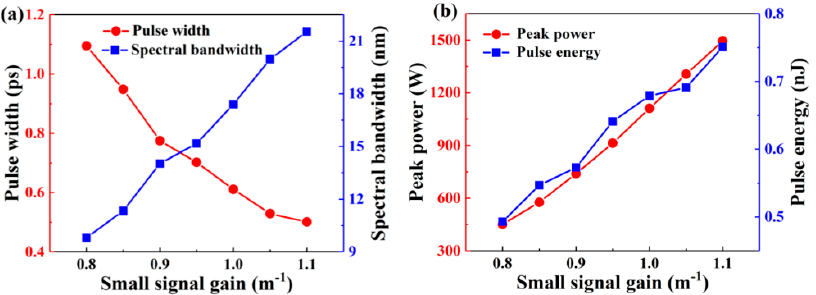
Figure 5. Output pulse characteristics of the passively mode-locked Er 3+ -doped fluoride fiber laser. ( a ) Pulse width and 3 dB spectral bandwidth and ( b ) peak power and pulse energy as a function of small signal gain.